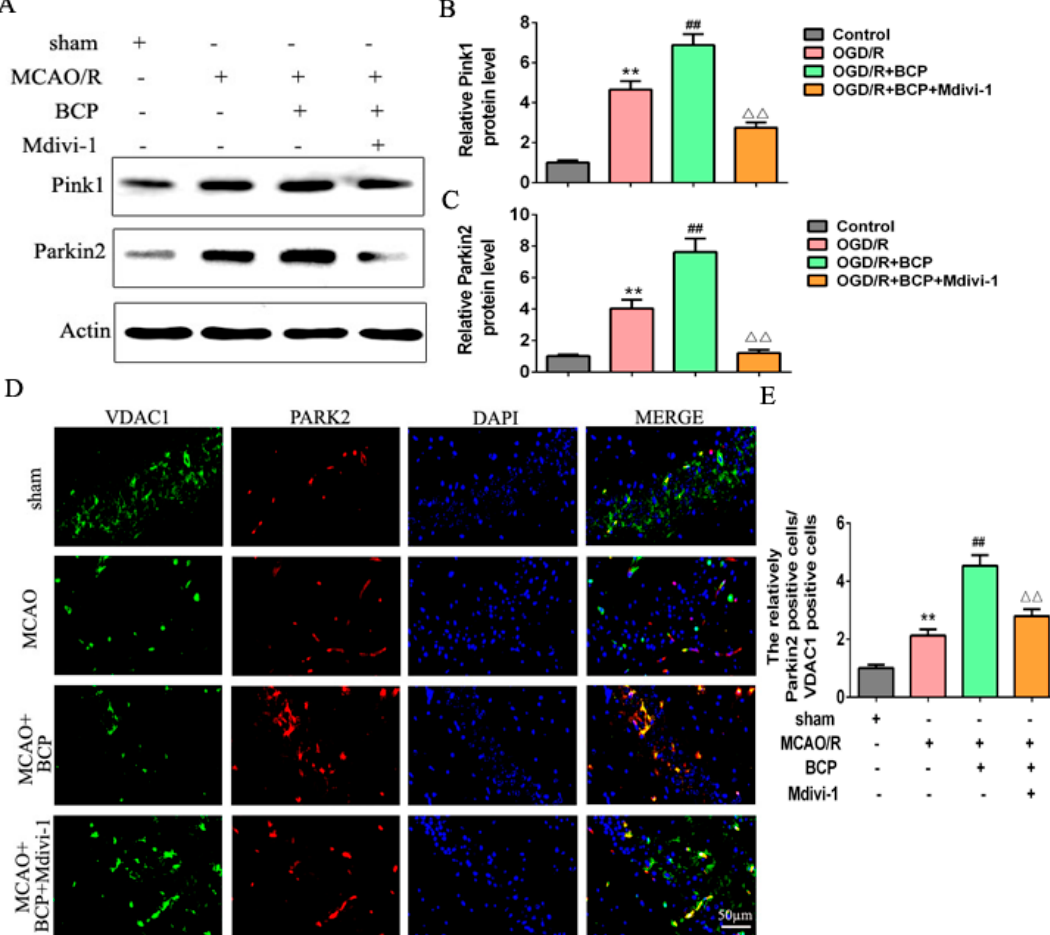
Figure 10. Pink1/Parkin2 pathway-dependent mitophagy is implicated in BCP-induced protection against CIR injury. ( A – C ) Representative Western blots showing protein levels of Pink1 and Parkin2. Protein levels were normalized to β -actin. ( D , E ) Double-immunofluorescence staining for VDAC1 and Parkin2 in the penumbra of ischemic hippocampal CA1 sections at 24 h after reperfusion. VDAC1 (red) and Parkin2 (green) double-stained cells (yellow) indicated mitophagy. (Scale bar = 50 µ m, 400 × magnification). (( A – E ), n = 6, ** p < 0.01 MCAO/R group vs. sham group; ## p < 0.01 MCAO/R + BCP group vs. MCAO/R group; (cid:52)(cid:52) p < 0.01 Mdivi-1 group vs. BCP